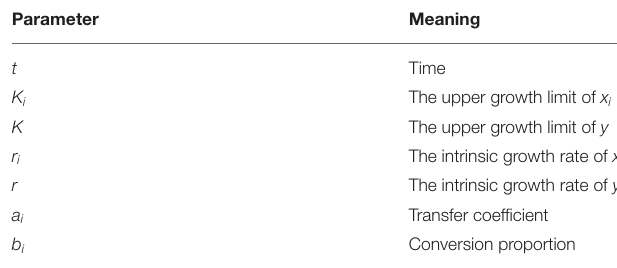
TABLE 1 | Parameter